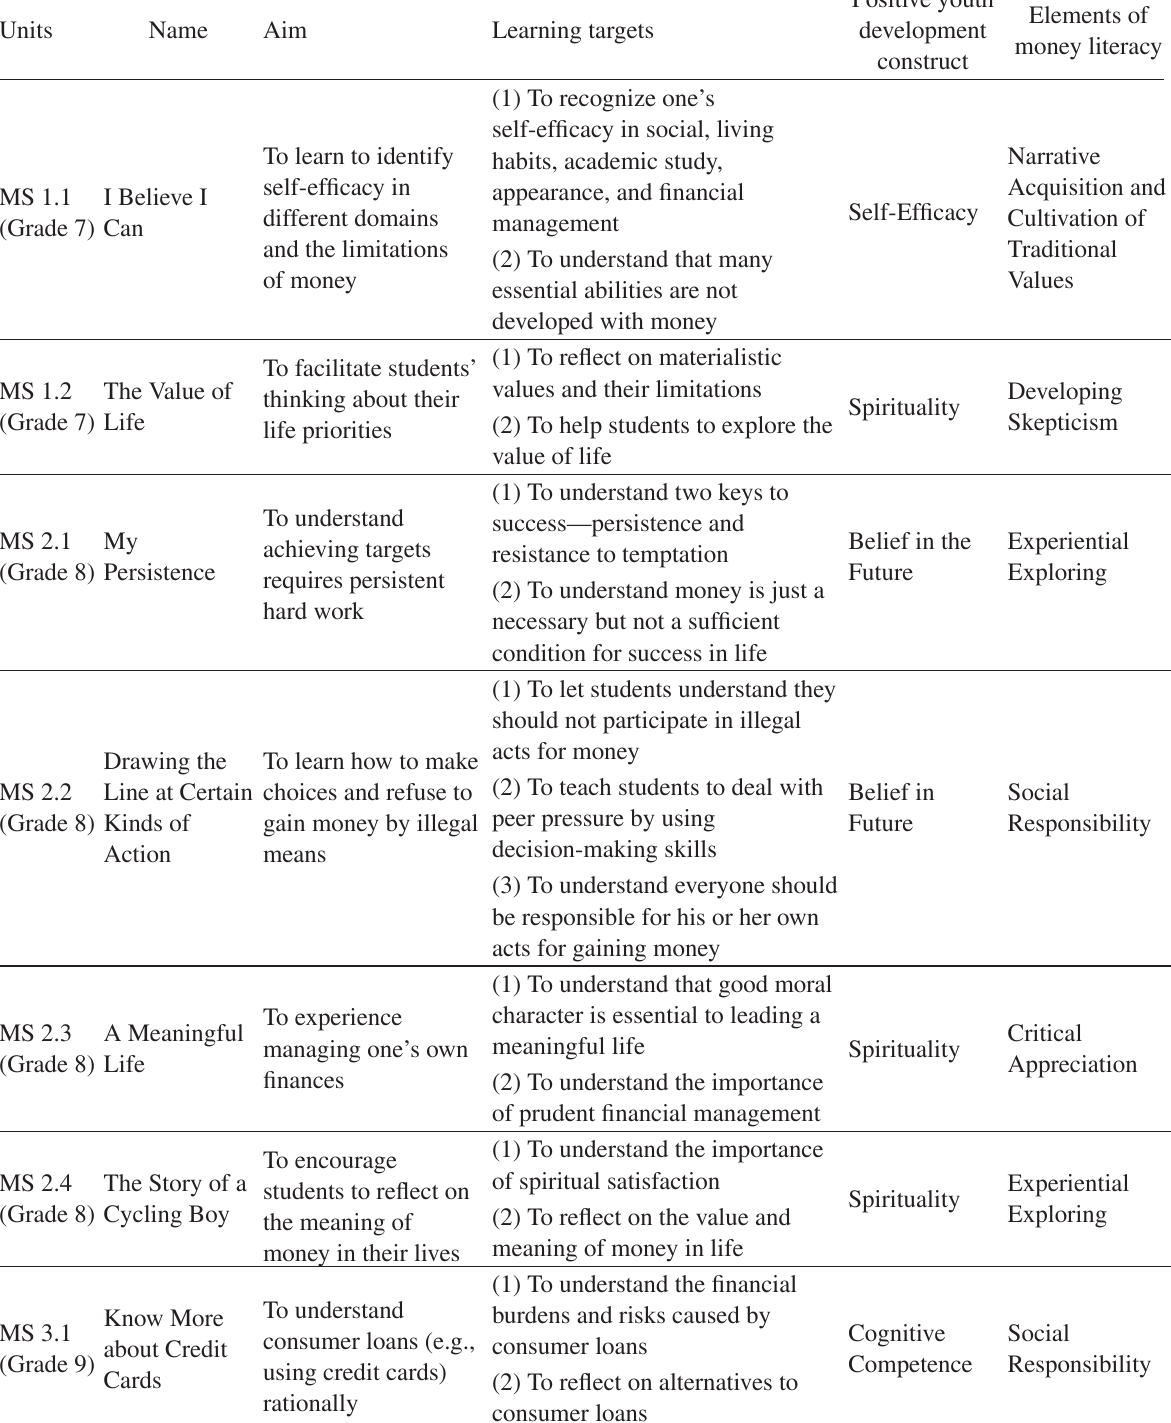
TABLE 2: The aims and learning targets of curriculum units for money literacy.